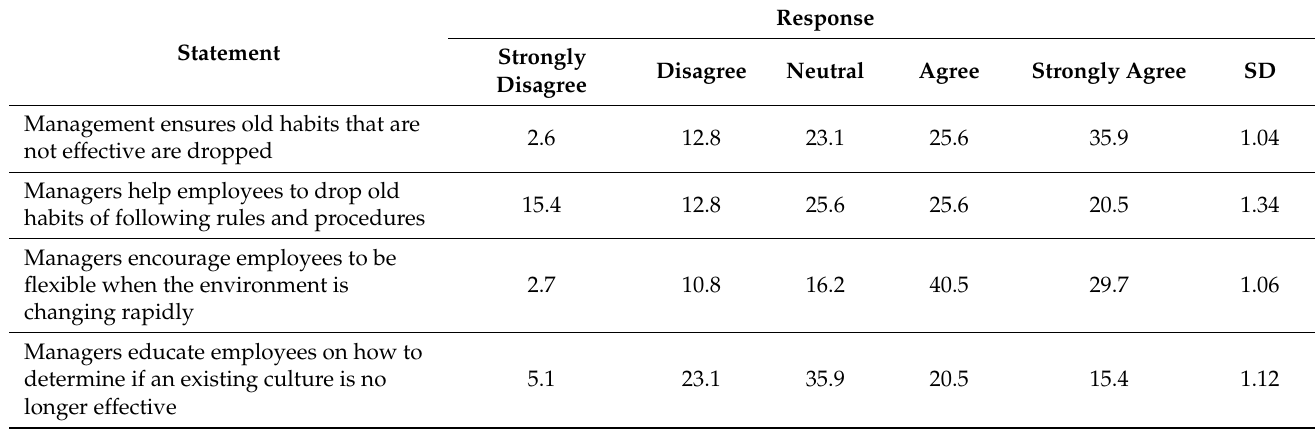
Table 1. Descriptive statistics for organizational culture change and performance at the unfreezing